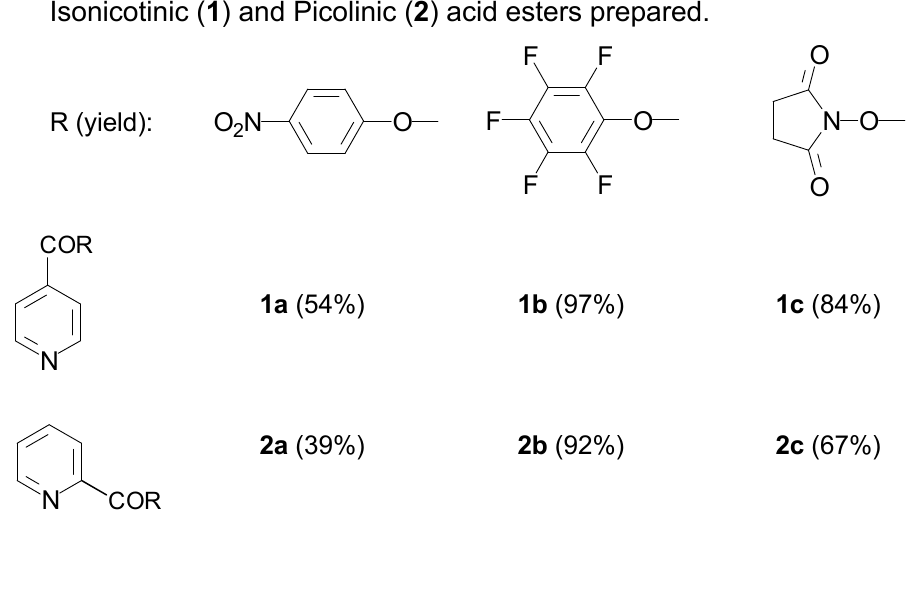
Isonicotinic ( 1 ) and Picolinic ( 2 ) acid esters